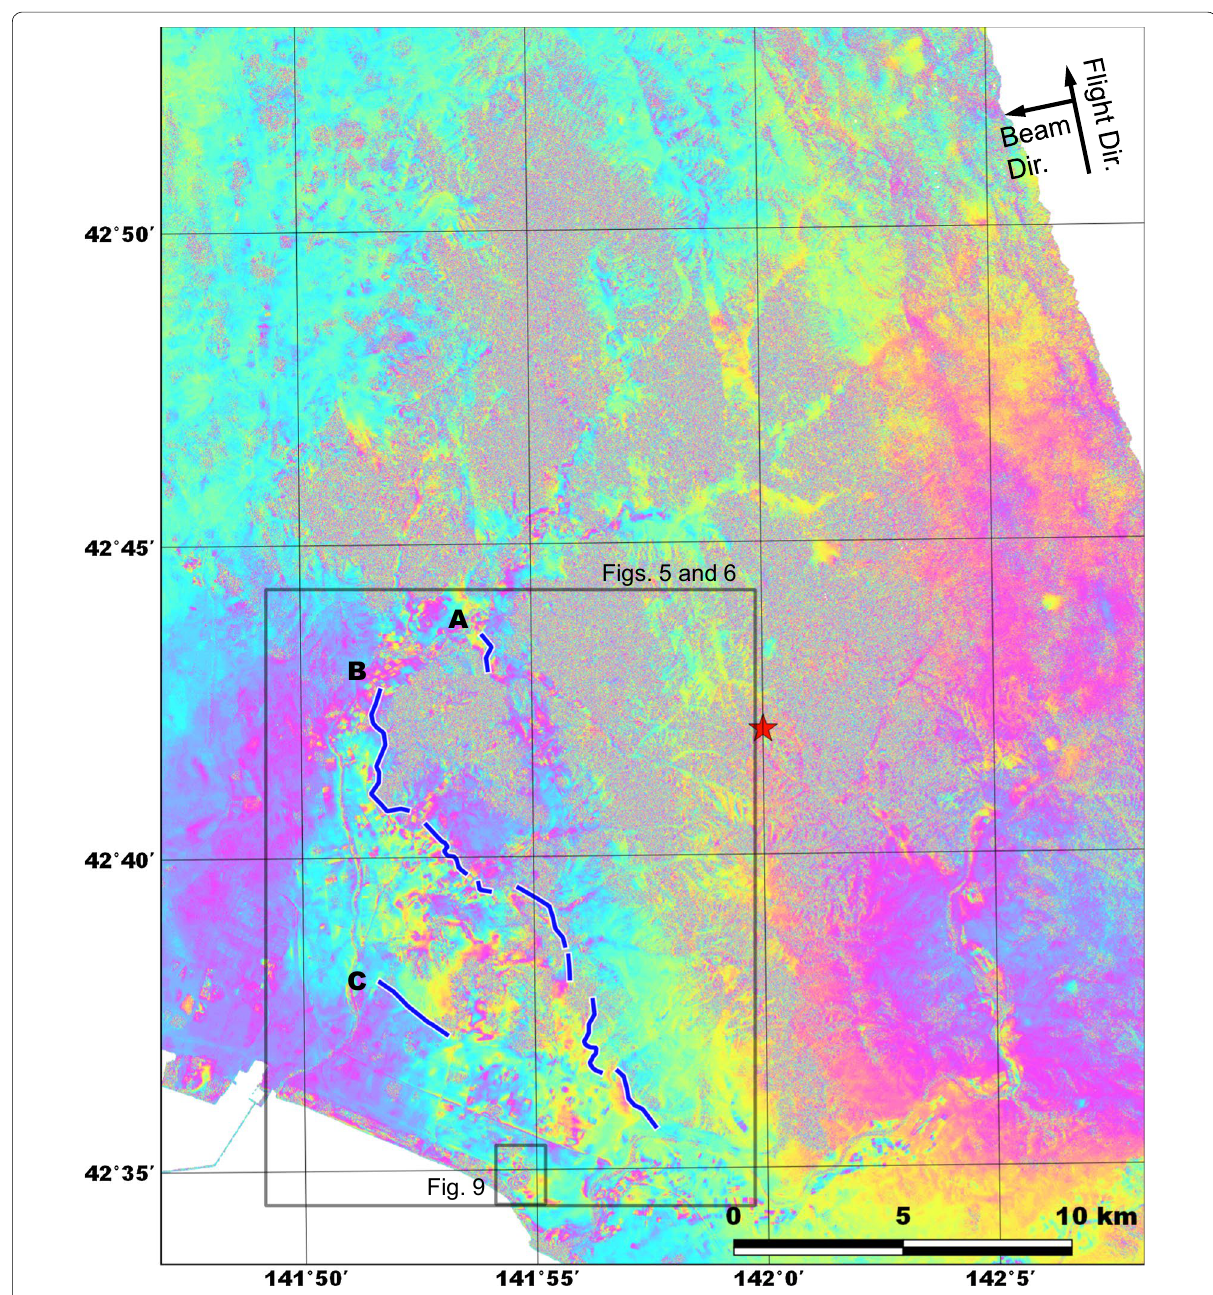
Fig. 3 ALOS-2 SAR interferogram of image pair 4 (Table 1) showing the linear surface displacements identified in this study. The red star shows the epicenter of the 2018 Hokkaido Eastern Iburi Earthquake (Earthquake Research Committee 2018). Rectangles show the area of other figures. Blue lines show the identified linear surface displacements (interferograms without these features are given in Additional file 1: Fig.